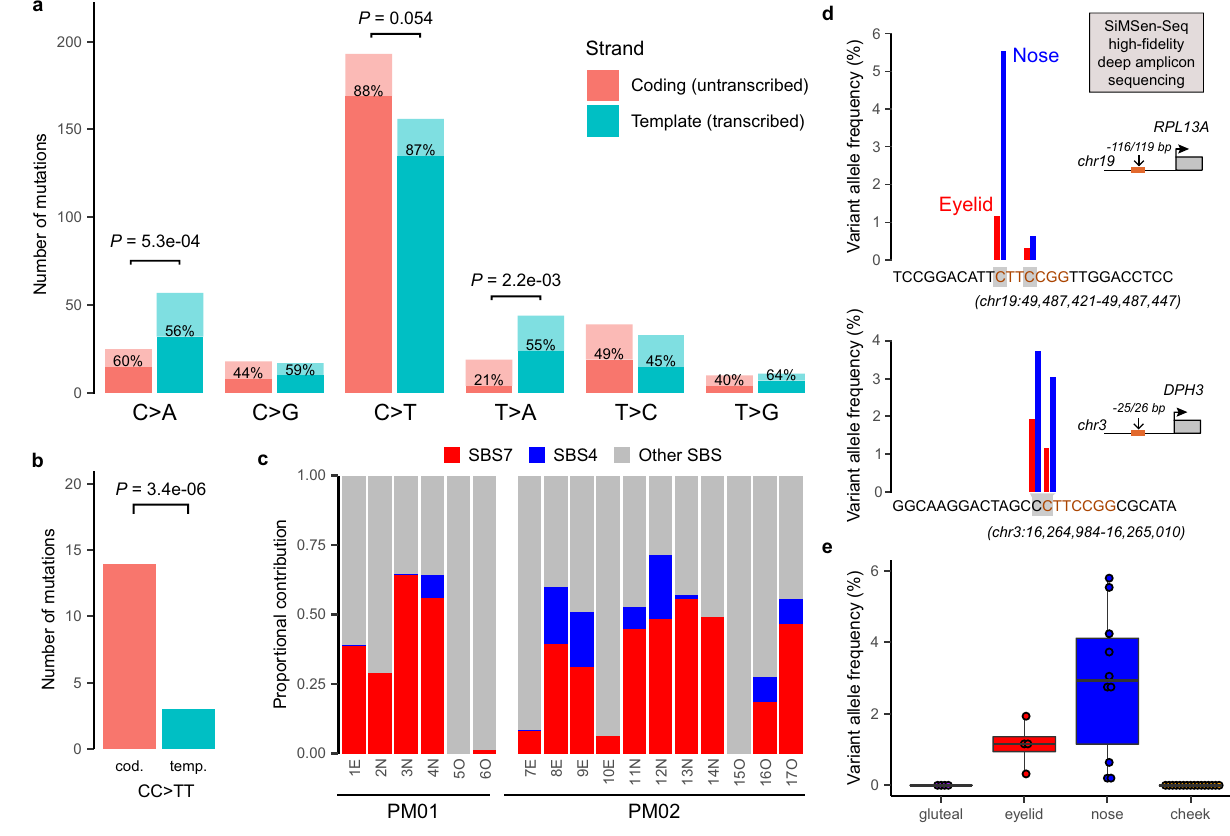
Figure 5. Detection of UV-induced somatic mutations in post-mortem epithelial tissues. ( a – c ) Deep (1000 ×) targeted sequencing results. ( a , b ) Bar plots representing the total number of single nucleotide variants ( a ) or dinucleotide variant (DNVs; b ), detected in epidermal skin (12 samples). Substitutions are stratified according to the occurrence of the pyrimidine on the coding (untranscribed) or template (transcribed) strand as indicated. Transcriptional strand bias tested using Poisson exact test. Bars are colored by strand as indicated and following the number of substitutions occurring in a dipyrimidine (dark, % indicated) or other sequence (light) context. ( c ) Proportion of known mutational signatures retrieved by analyzing the cosine similarity between the distribution of 96 trinucleotide substitution types and 30 known COSMIC mutational signatures. Single base substitution signatures (SBS) 4 and 7 colored as indicated. ( d , e ) SiMSen sequencing of well-known UV hotspot mutations in RPL13A and DPH3 promoters. ( d ) Data from PM02 for illustration, 2 hot spots each as indicated by grey shaded nucleotides, sequence indicated in orange. ( e ) Boxplot summarizes results for both study subjects, all hotspots and sample locations as indicated. Boxplot indicates median values and lower/upper quartiles with whiskers extending to 1.5× the interquartile range. Dots show individual data